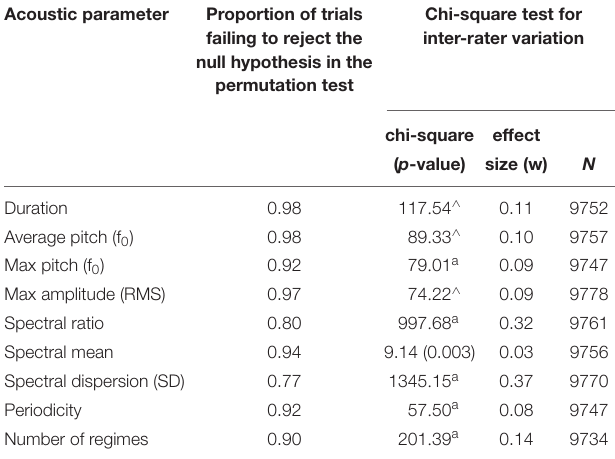
TABLE 5 | Inter-rater differences across 39